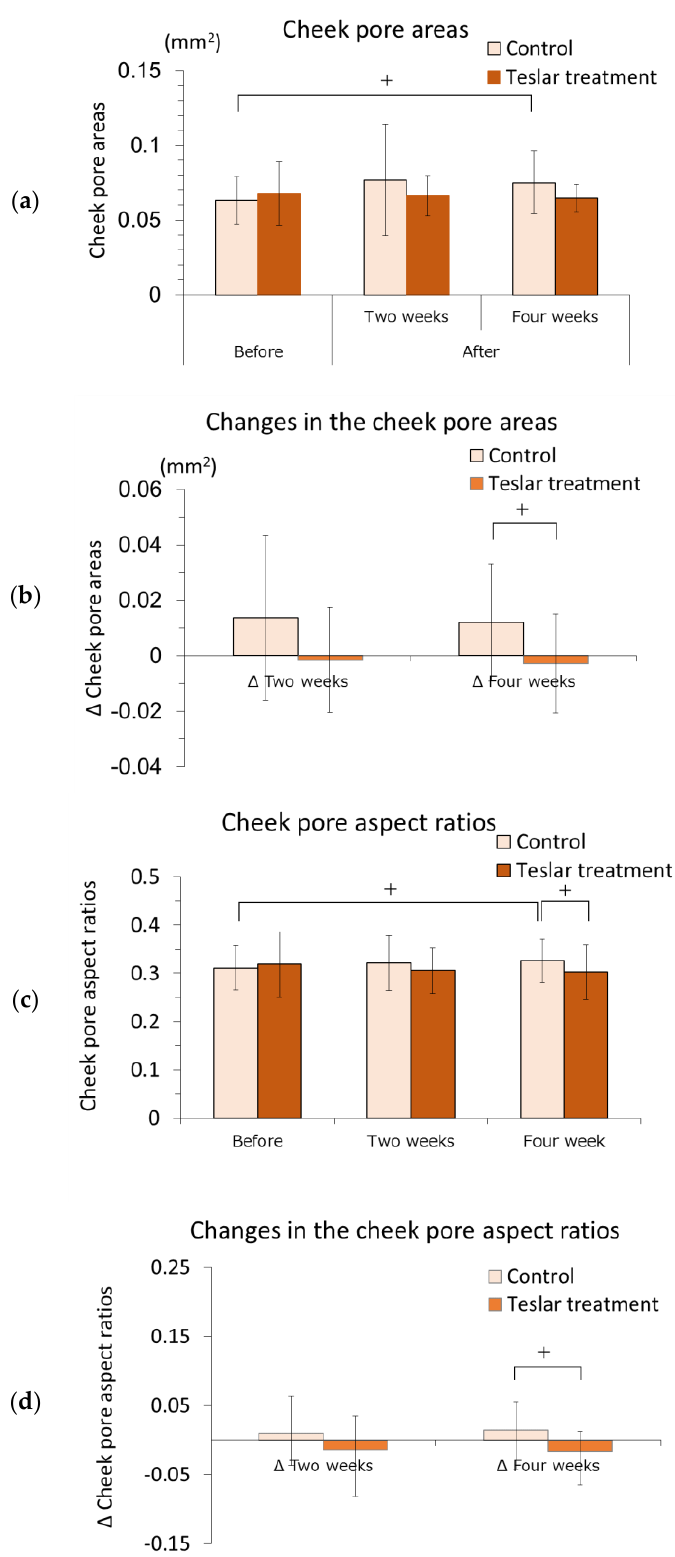
Figure 2. Cheek pore areas, changes in cheek pore areas, cheek pore aspect ratios and changes in the cheek pore aspect ratios—Controls vs. Teslar treatments. ( a ) Cheek pore areas; ( b ) changes in cheek pore areas; ( c ) cheek pore aspect ratios and ( d ) changes in the cheek pore aspect ratios. The results are expressed as the mean ± standard deviation of twelve experiments. + p < 0.1.